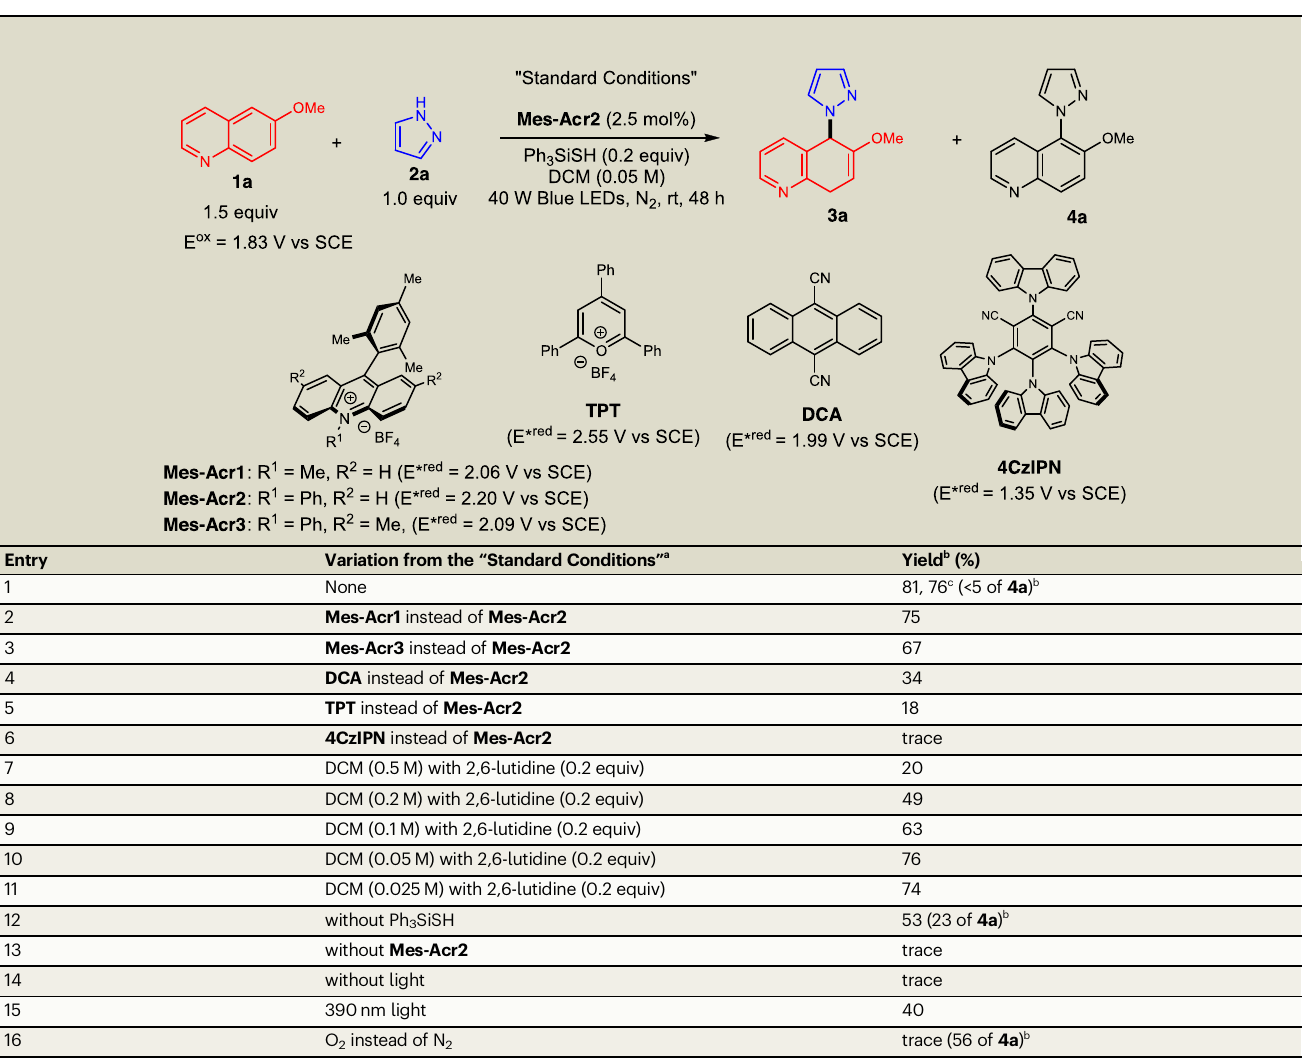
Table 1 | Exploration and optimization of reaction